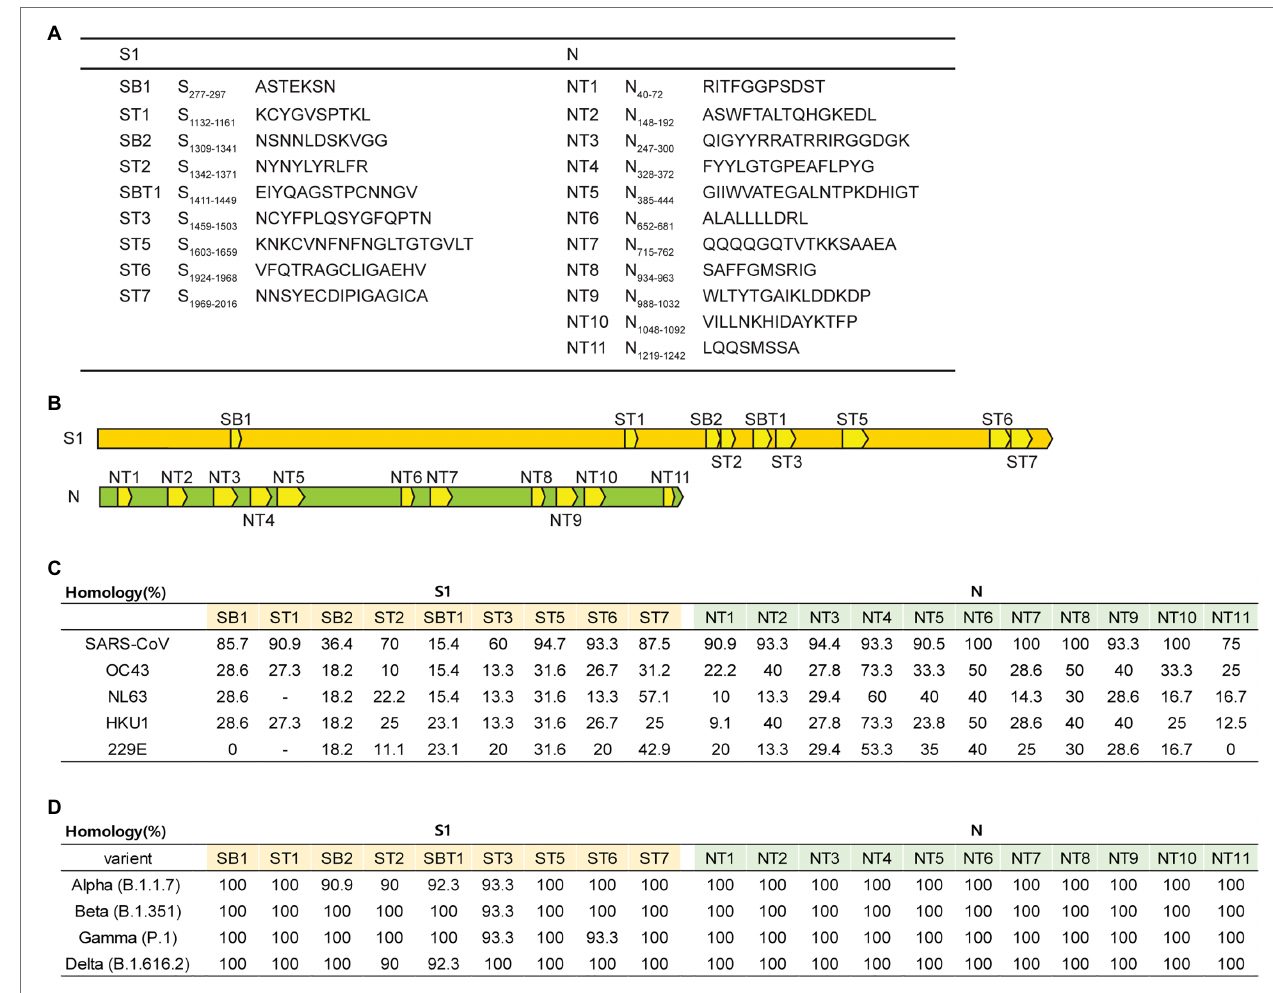
FIGURE 1 | Overview of the 20 peptides derived from severe acute respiratory syndrome coronavirus 2 (SARS-CoV-2) S and N proteins. (A) List of 20 peptide sequences. (B) Location of the 20 designed peptides in the S and N proteins. (C,D) Homology percentage of each peptide to other coronaviruses [SARS-CoV, OC43, NL63, HKU1, 229E, and SARS-CoV-2 variants ( α , β , γ , and δ